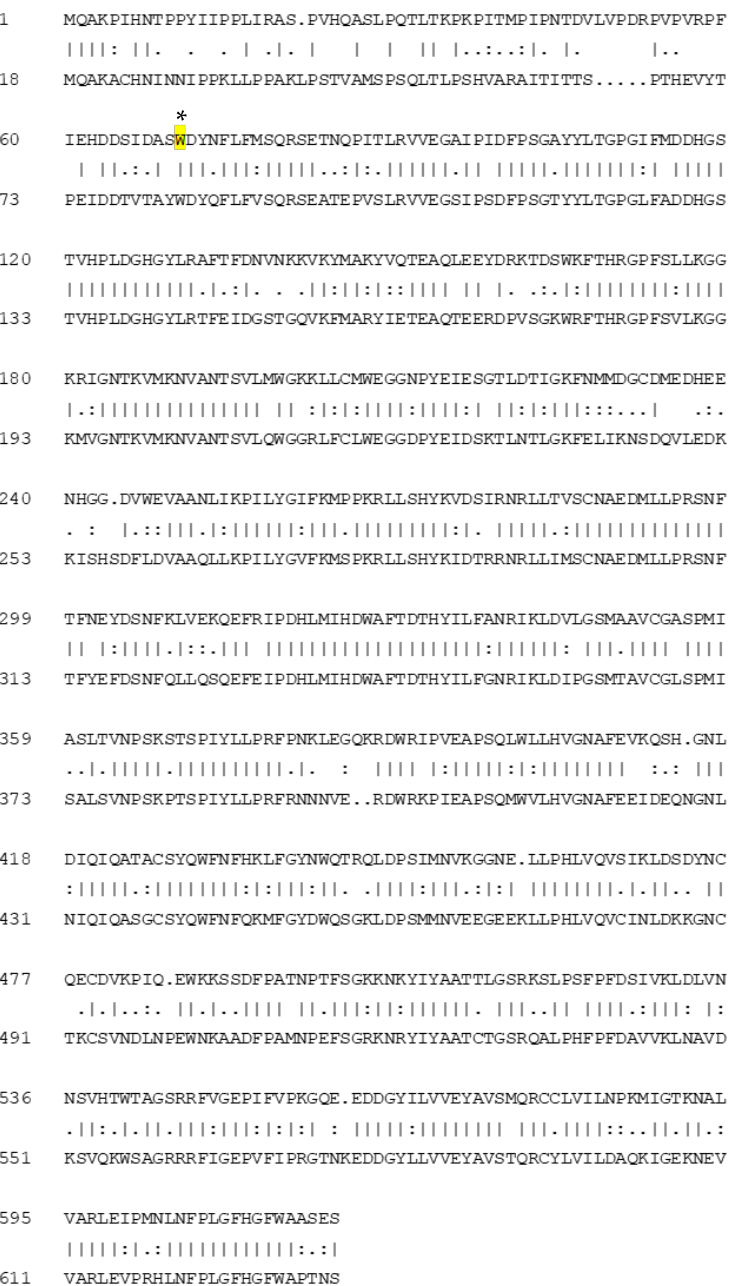
Figure 3. Chickpea and tomato CCD7 protein sequence homology. The upper and lower sequences are of chickpea and tomato CCD7, respectively. Identical amino acids are indicated by a solid line, and similar amino acids are indicated by one or two dots according to their similarity levels. The mutated amino acid in CCD7 of broomrape-resistant line CCD7M14, at position 70 (84 according to tomato) is indicated in yellow and marked by an